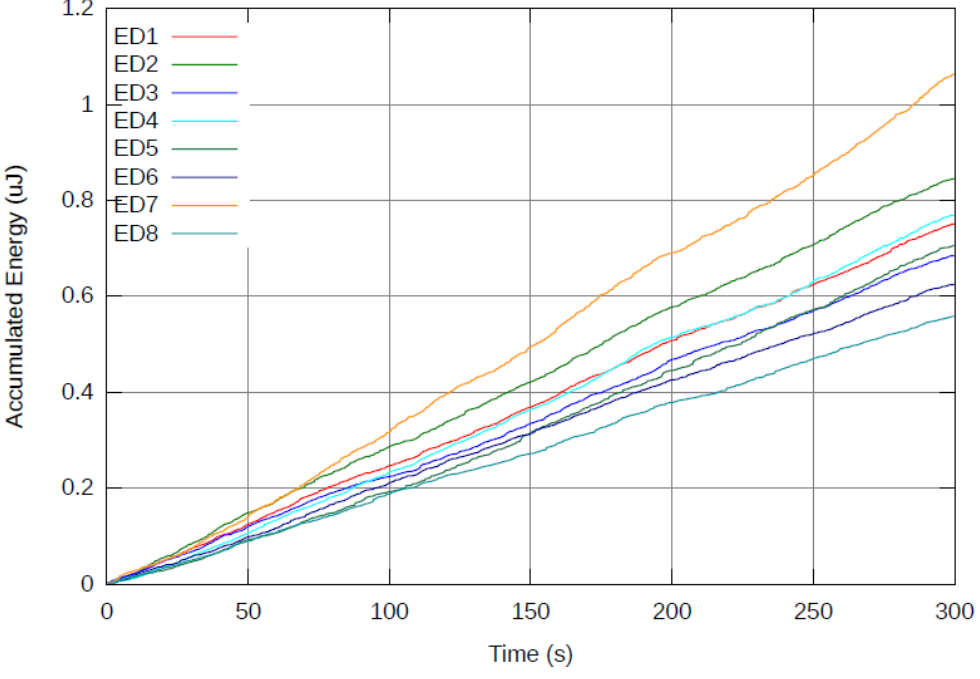
Figure 6. Accumulated energy spent by each end device over time for the proposed algorithm using M = 100. Note that energy consumption is balanced and all nodes consume the same amount of accumulated energy over